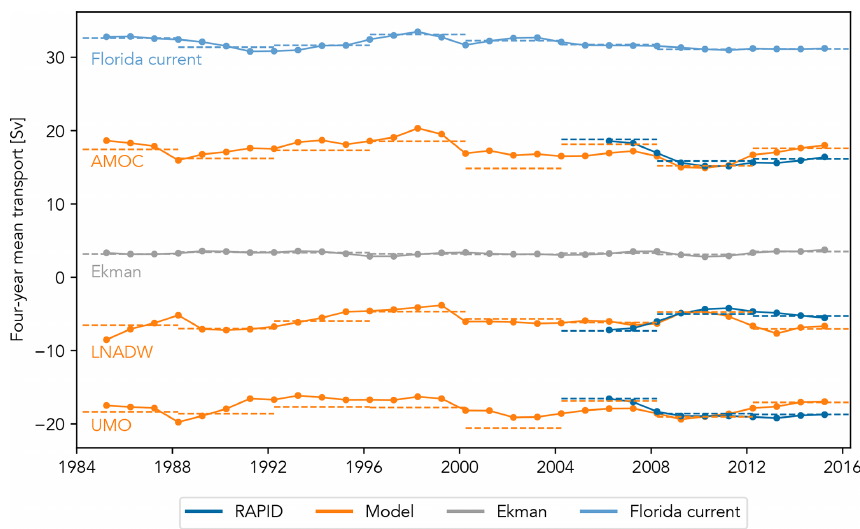
Figure 9. Four-year means (dashed lines) from 1984 to 2016 and the Gaussian-weighted rolling mean with a 4-year window (solid line), with the markers showing the mid-point, for AMOC, LNADW, and UMO transports estimated by the relevant regression models (orange) and from RAPID observations (dark blue). The 4-year and rolling means for Florida Current (light blue) and Ekman (dark grey) transports are also